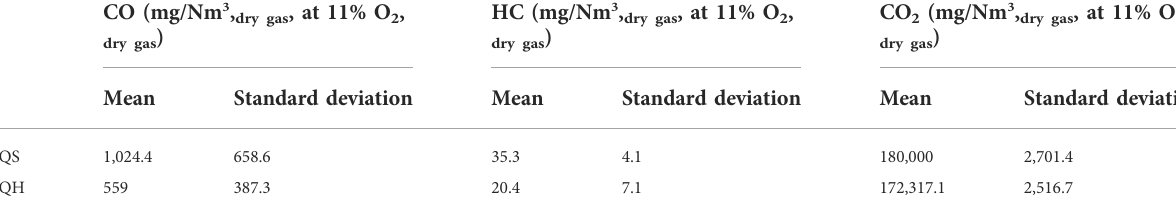
TABLE 4 Flue gas composition (mean and standard deviation) observed during the pyrolysis experiments with QS, and QH. CO (mg/Nm 3 , dry gas , at 11% O 2 , dry gas